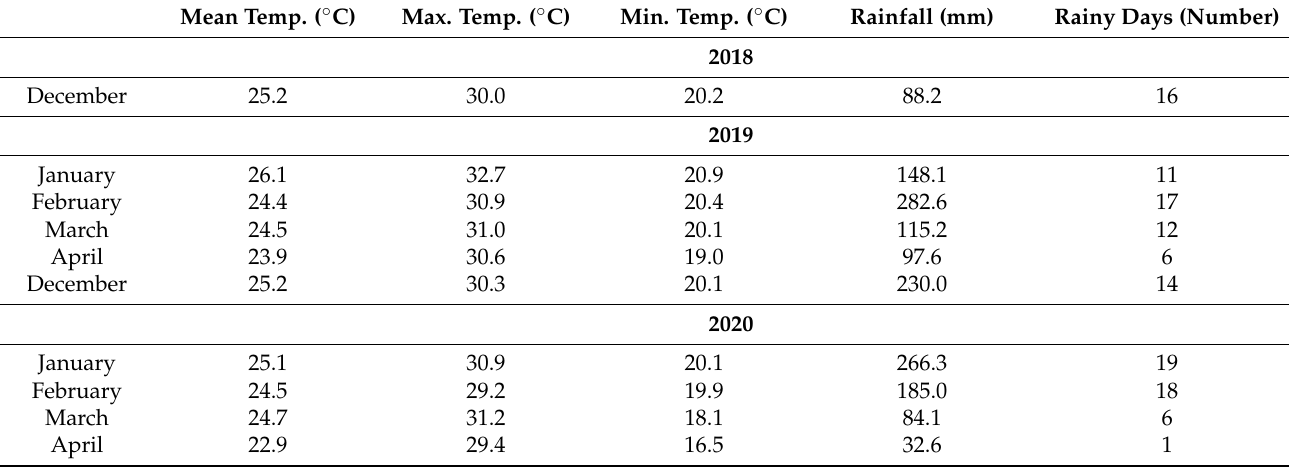
Table 1. Monthly temperatures, rainfall and rain events during experimental seasons 2018/2019 a and 2019/2020 b . Mean Temp. ( ◦ C) Max. Temp. ( ◦ C) Min. Temp. ( ◦